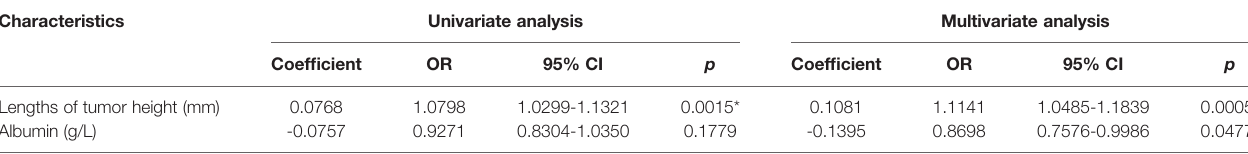
Lengths of tumor height